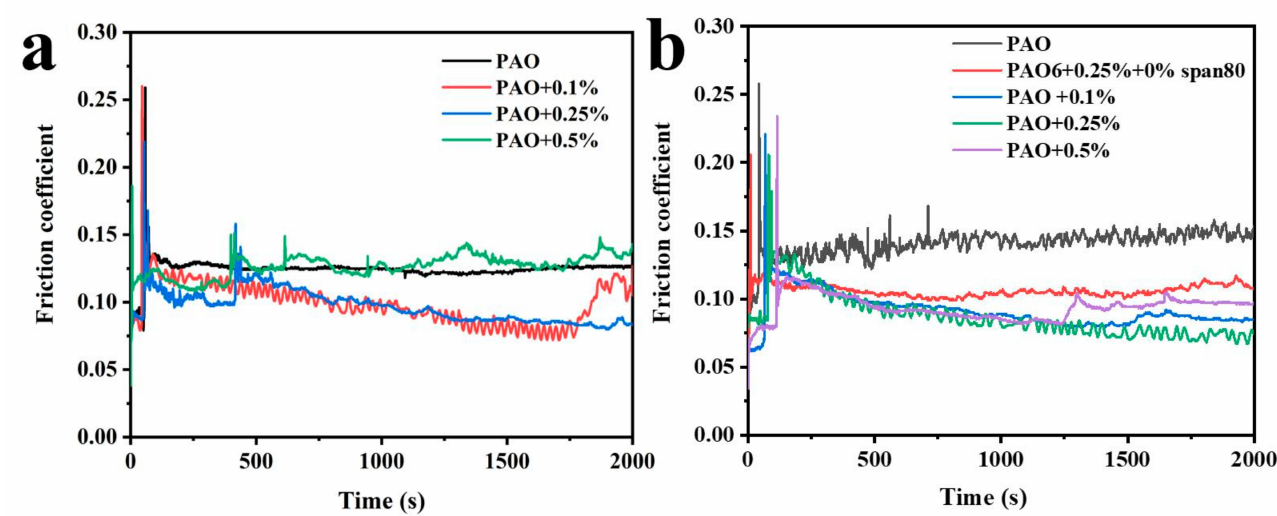
Figure 4. The coefficient of friction (COF) curve of IF–WS 2 with different contents at temperatures ( a ) 75 °C and ( b ) 100 °C with the load of 392 N and rotation speed of 1200 rpm.